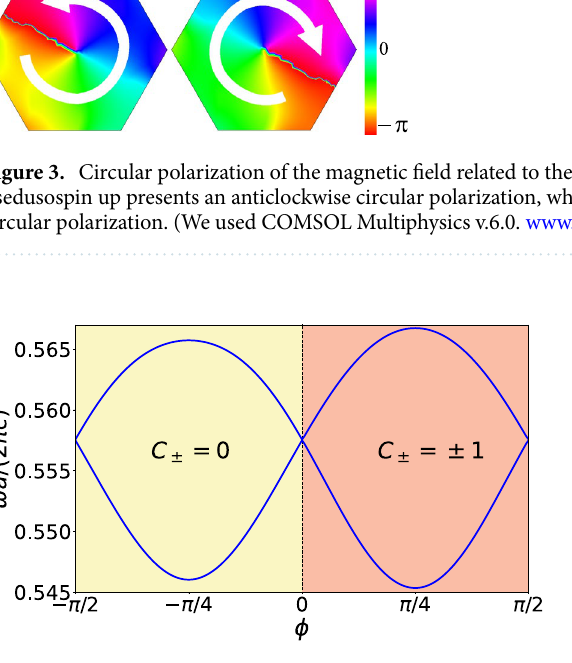
a / 3 , r R / 2 , and ε 0.13 a , d 11.7 . For φ 0 and φ π/ 2 , the bands are = = = = = | | =